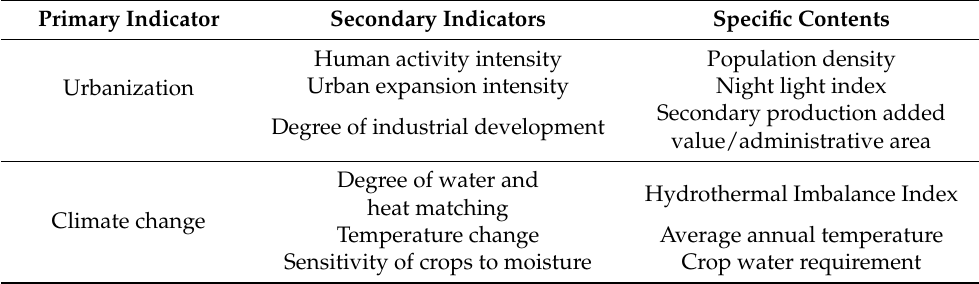
Table 2. Detecting indexes of influencing factors of agricultural production space suitability. Primary Indicator Secondary Indicators Specific Contents Human activity intensity Population density Urban expansion intensity Night light index Urbanization Degree of industrial development